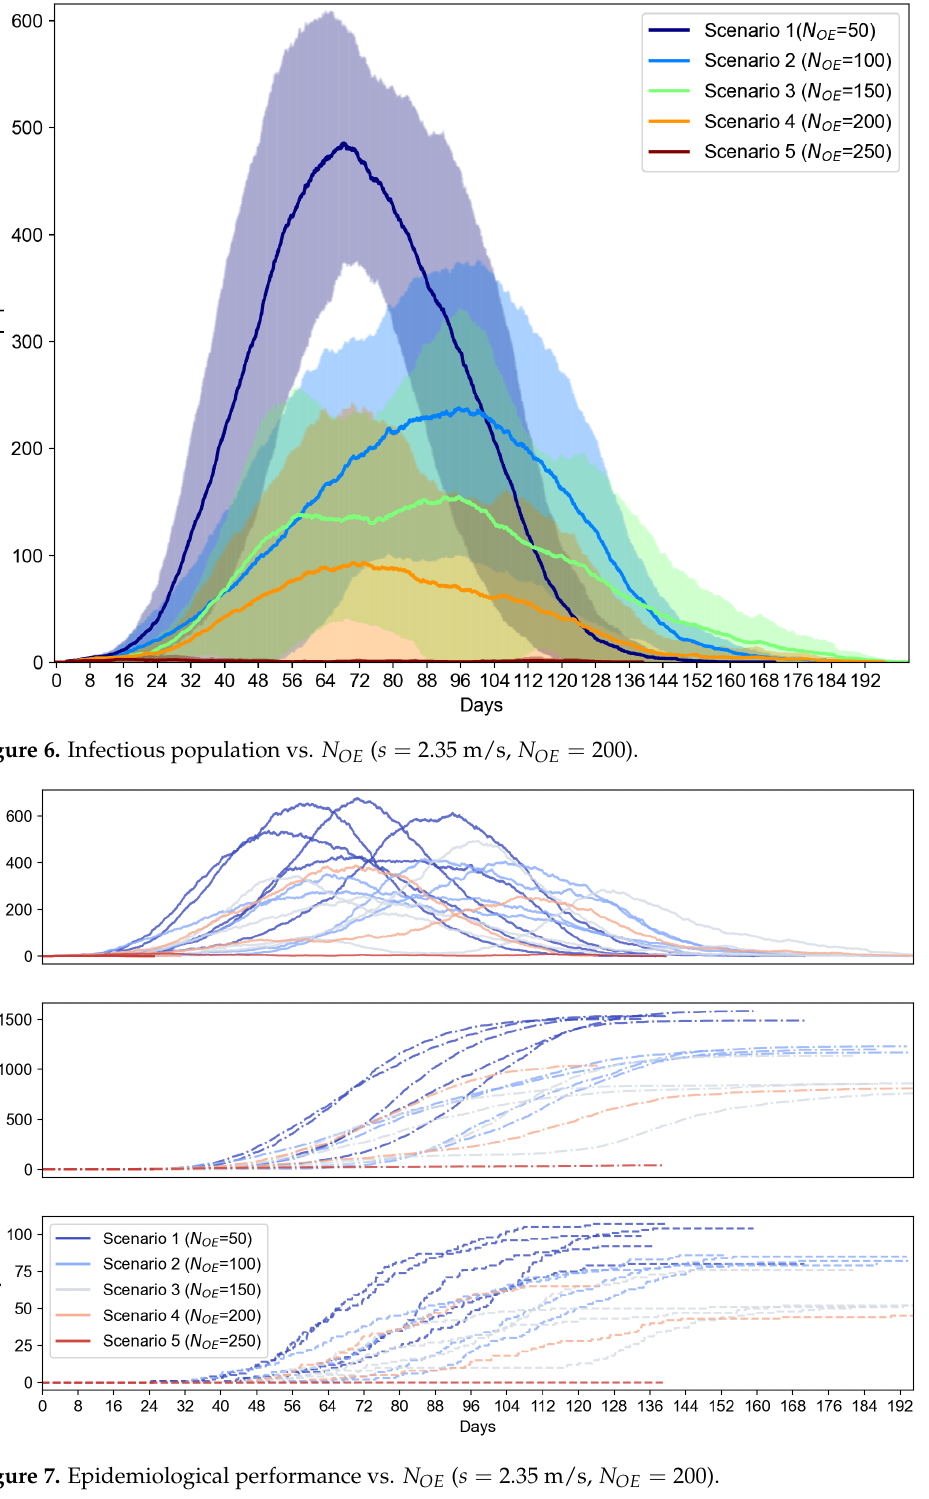
Figure 7. Epidemiological performance vs. N OE ( s = 2.35 m/s, N OE =